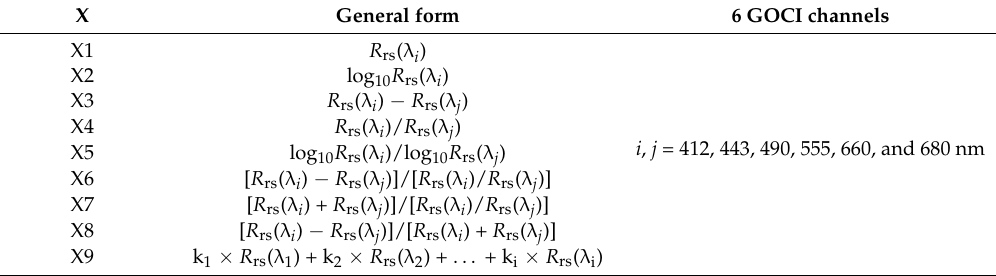
Table 1. Band combinations used in this study; X1 to X9 indicate the nine forms of X. X General form 6 GOCI